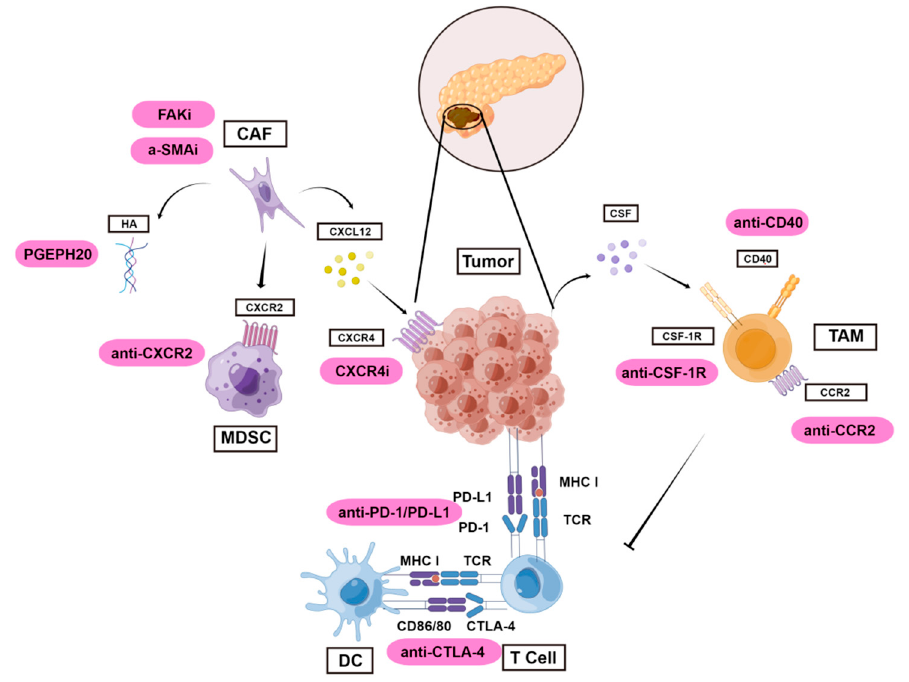
Figure 1. Landscape of immunomodulatory and stroma-depleting strategies to treat pancreatic cancer. Various immune cells and stromal cells constitute the pancreatic tumor microenvironment and can provide druggable targets. Promising multi-modal therapy usually involves two mechanistically independent immunomodulatory strategies or one immunomodulatory therapy combined with stroma-depleting therapy. Enhancing antigen presentation, depleting or inhibiting immunosuppres- sive components, or activating cytotoxic T cells are immunomodulatory strategies that can reinforce the antitumor efficacy of other therapies. APC, antigen-presenting cell; α -SMA, α -smooth muscle actin; CAF, cancer-associated fibroblast; CCR, chemokine receptor; CSF, colony-stimulating factor; CSF-1R, colony-stimulating factor-1 receptor; CTLA-4, Cytotoxic T-lymphocyte antigen 4; CXCR, C-X-C chemokine receptor; DC, dendritic cell; FAK, focal adhesion kinase; FAP, fibroblast activation protein; HA, hyaluronic acid; MDSC, myeloid-derived suppressor cell; MHC, major histocompability complex; TAM, tumor-associated